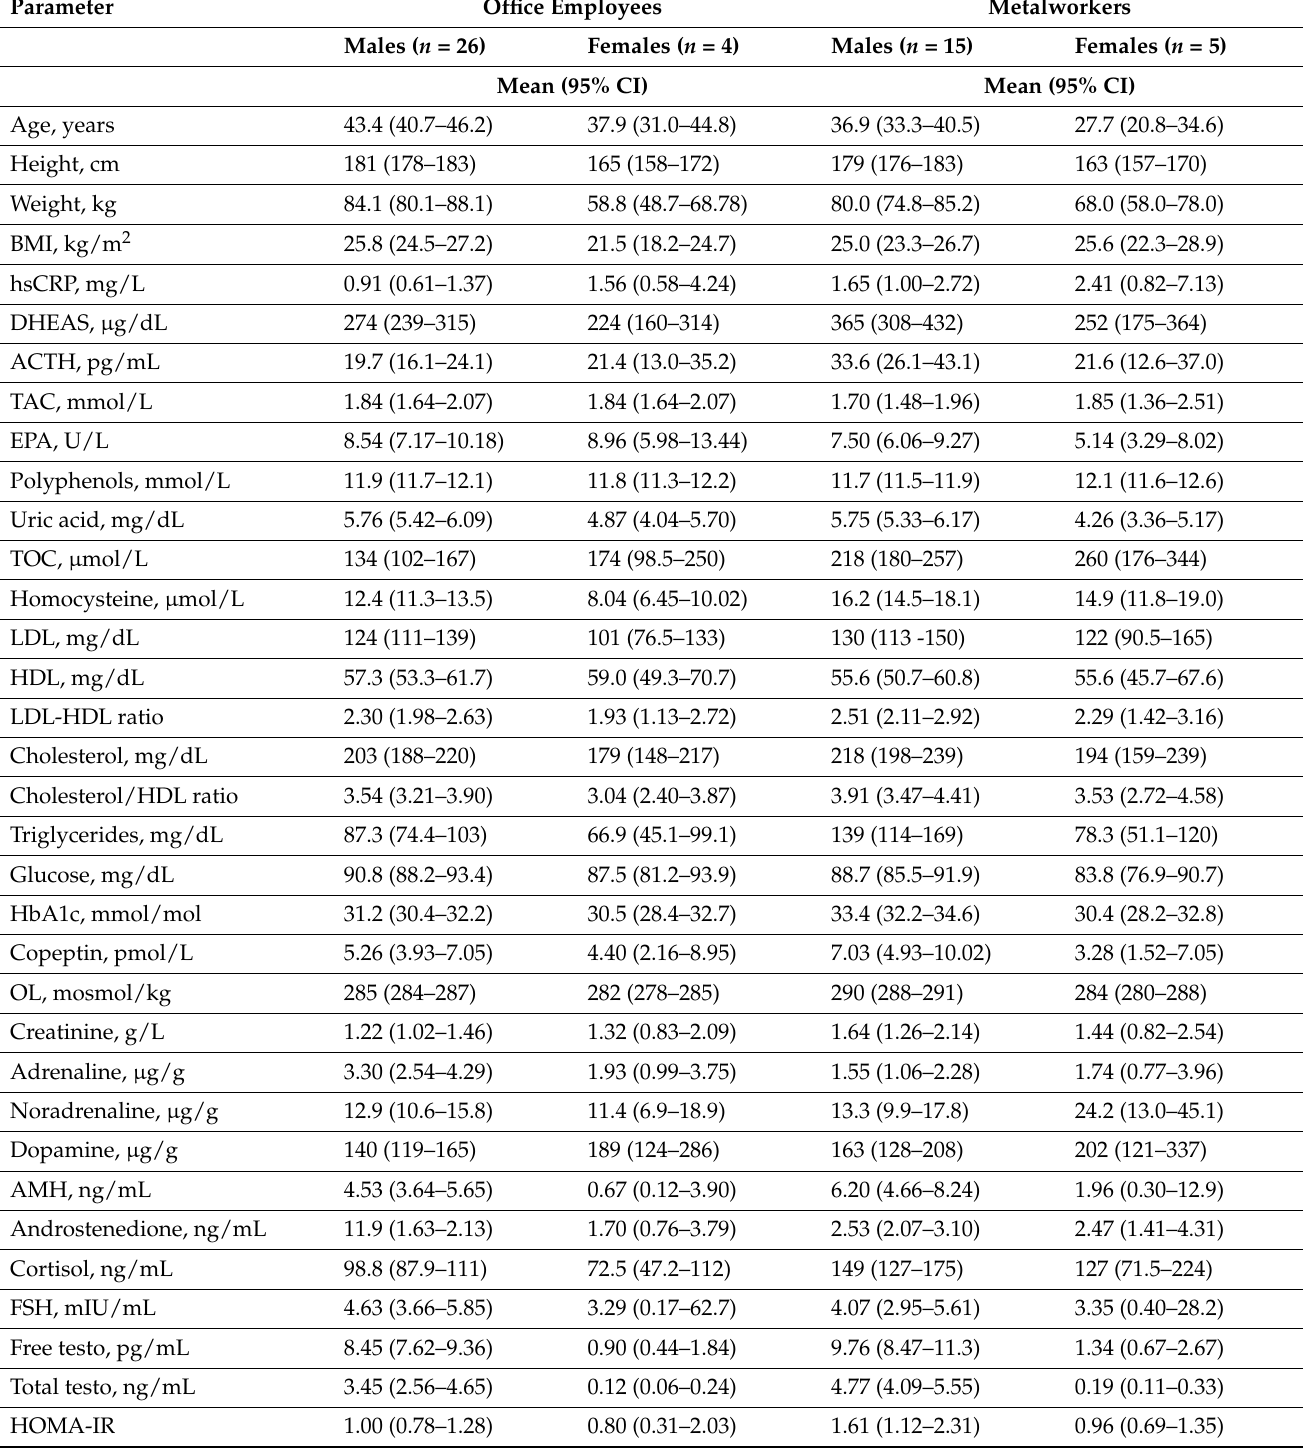
Table 2. Comparison of oxidative and psychological stress, inflammation, and endocrinological parameter between males and females in office employees and